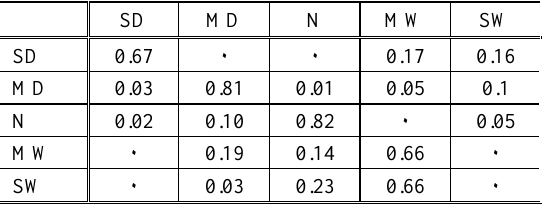
Table II: Probability model for drought based on VCI